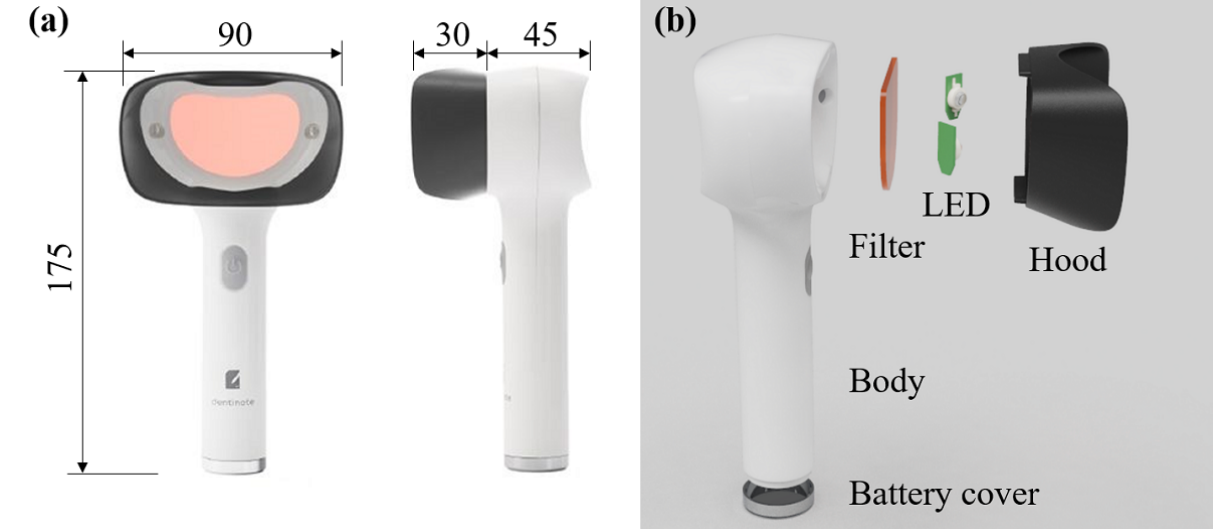
Figure 2. Light-induced fluorescence device for monitoring oral health: (a) dimensions (mm) and (b) components.